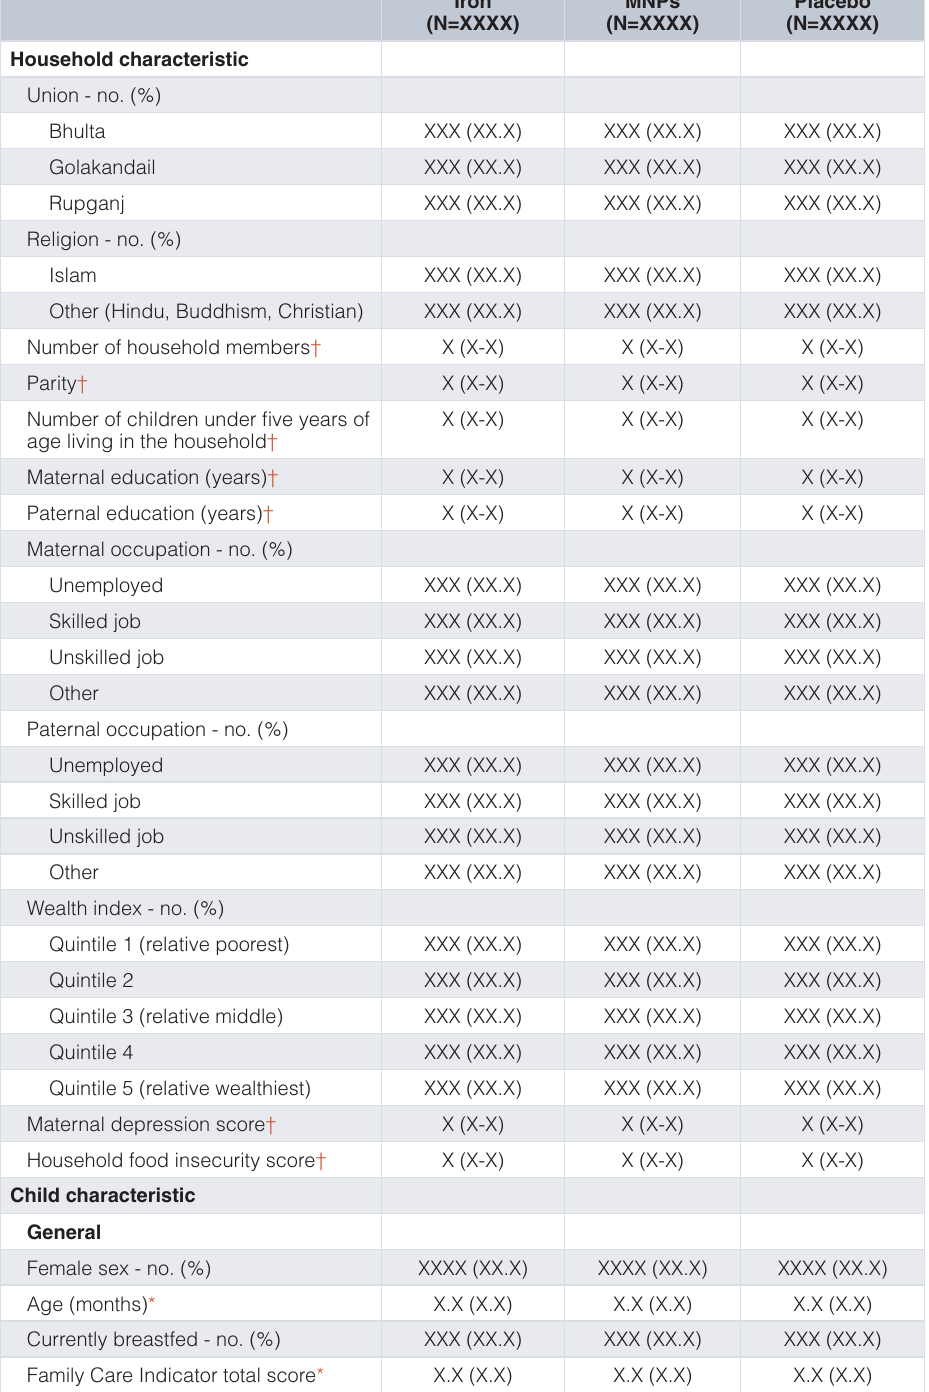
Iron MNPs Placebo (N=XXXX) (N=XXXX) (N=XXXX)